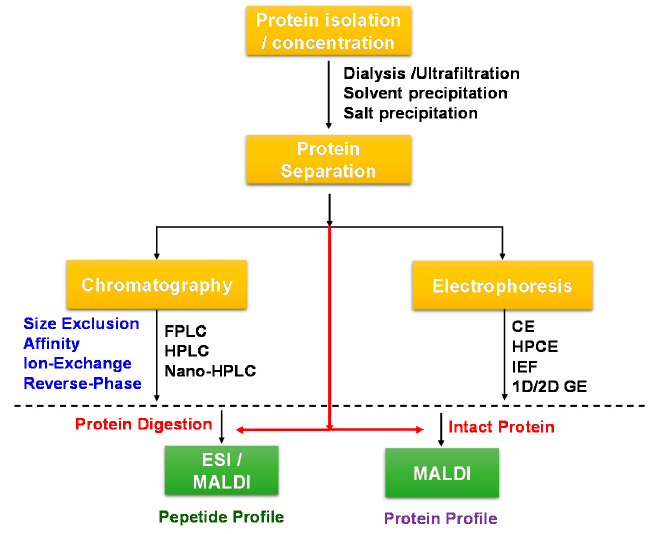
Figure 1. Typical workflow for wine protein characterisation .